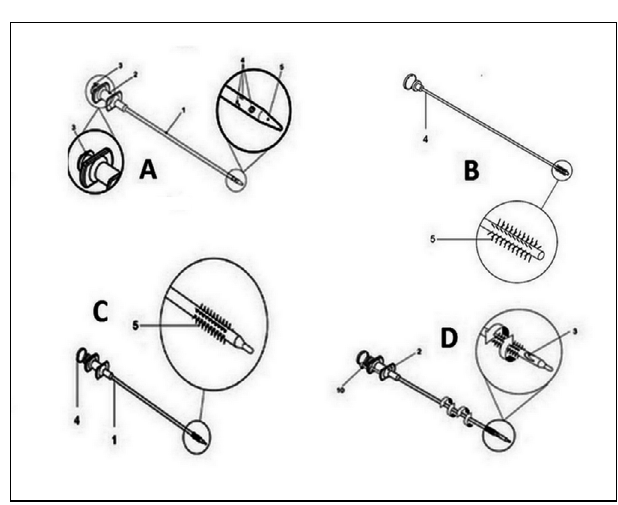
Fig. 1 - Instrument Design. A - External needle; B - Lateral holes for infusion; C - Blunt tip punch + brush mandrel; D - Internal mandrel.